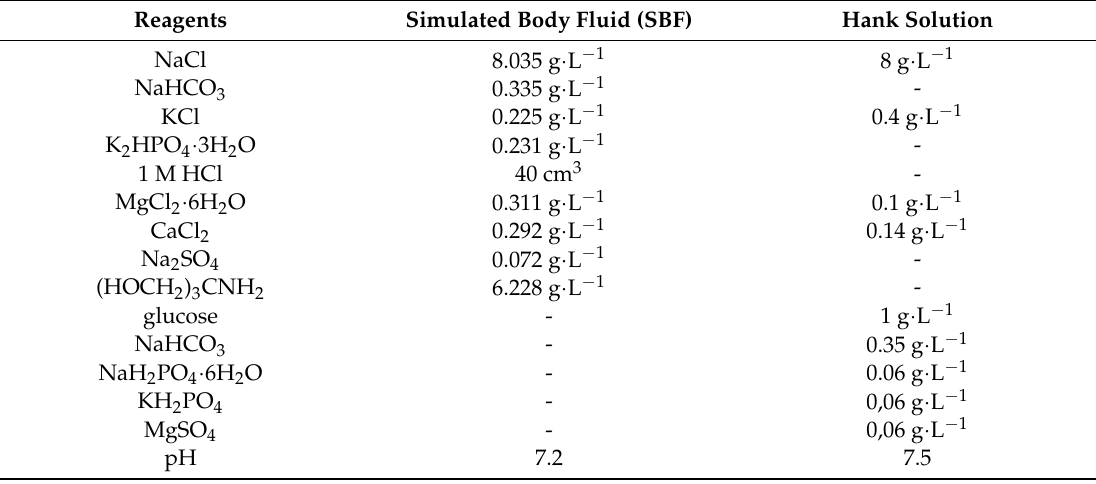
Table 1. Chemical composition and reagents of the liquids used for surface free energy